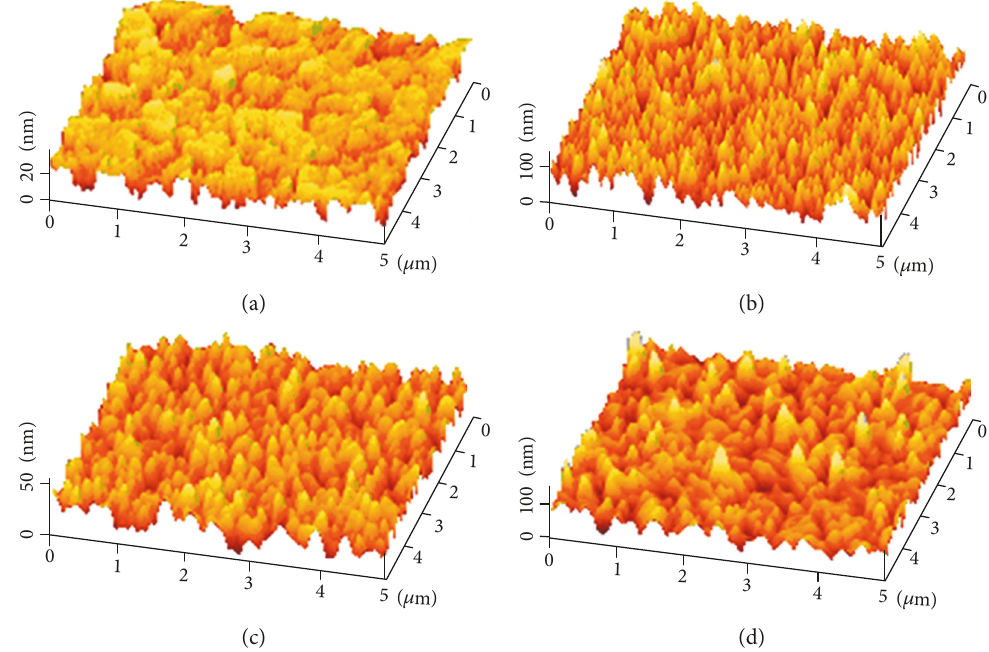
Figure 7: AFM images of ITO/glass (a), CuSCN/ITO/glass (b), CH CuSCN/ITO/glass (d). The RMS roughness values are 4.6, 19.3, 7.6, and 17.0nm, respectively. Reprinted with permission from [46].